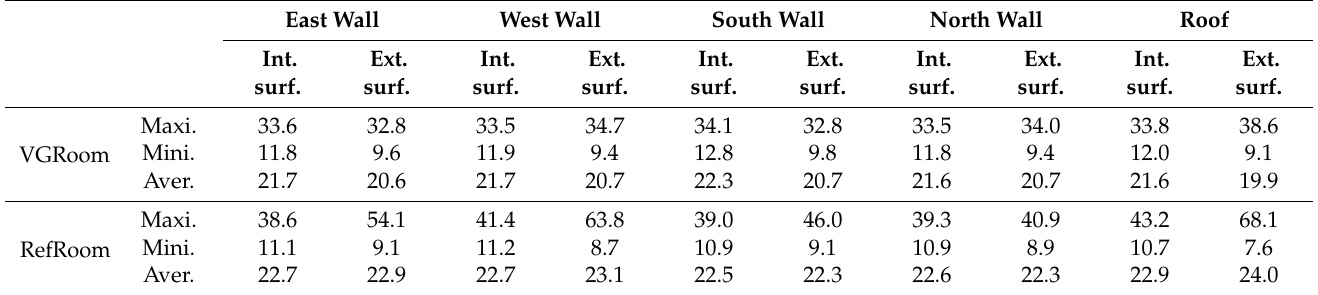
Table 4. Summary of internal and external surface temperatures of walls and roofs ( ◦